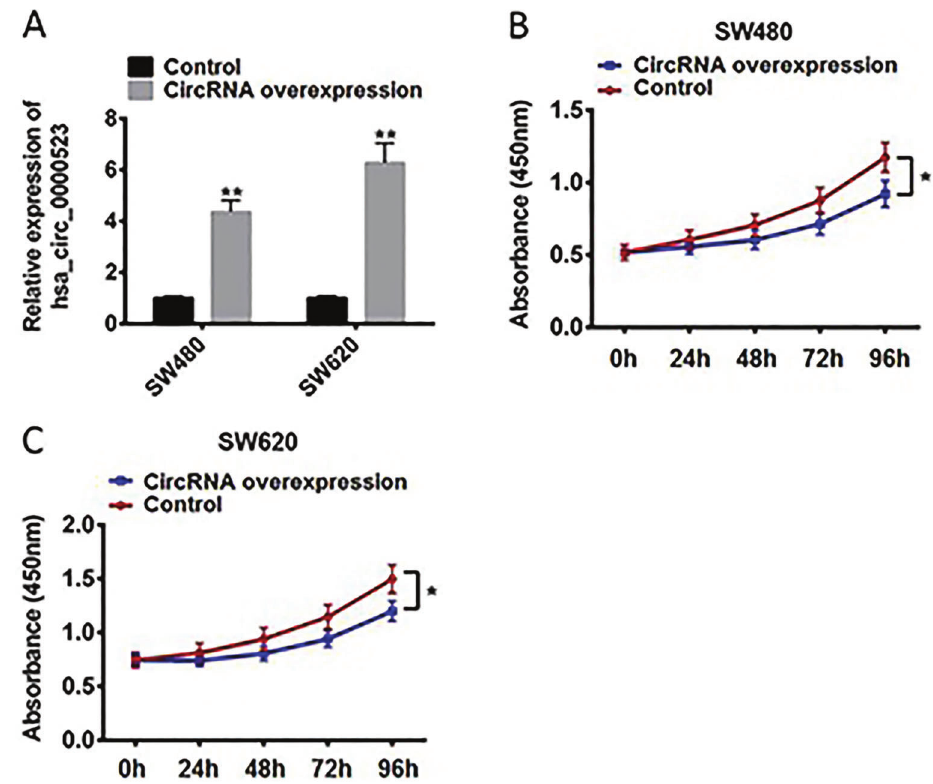
Figure 2. A , hsa_circ_0000523 expression levels in SW480 and SW620 cells after hsa_circ_0000523 overexpression using lentiviral expression systems. CircRNA expression levels were assessed by qPCR and normalized to GAPDH. Cell viability of SW480 ( B ) and SW620 ( C ) were assessed using CCK8 assay after hsa_circ_0000523 overexpression. The assays were performed in triplicate inde- pendently. Data are reported as means ± SE. *P o 0.05. **P o 0.01 (ANOVA or t